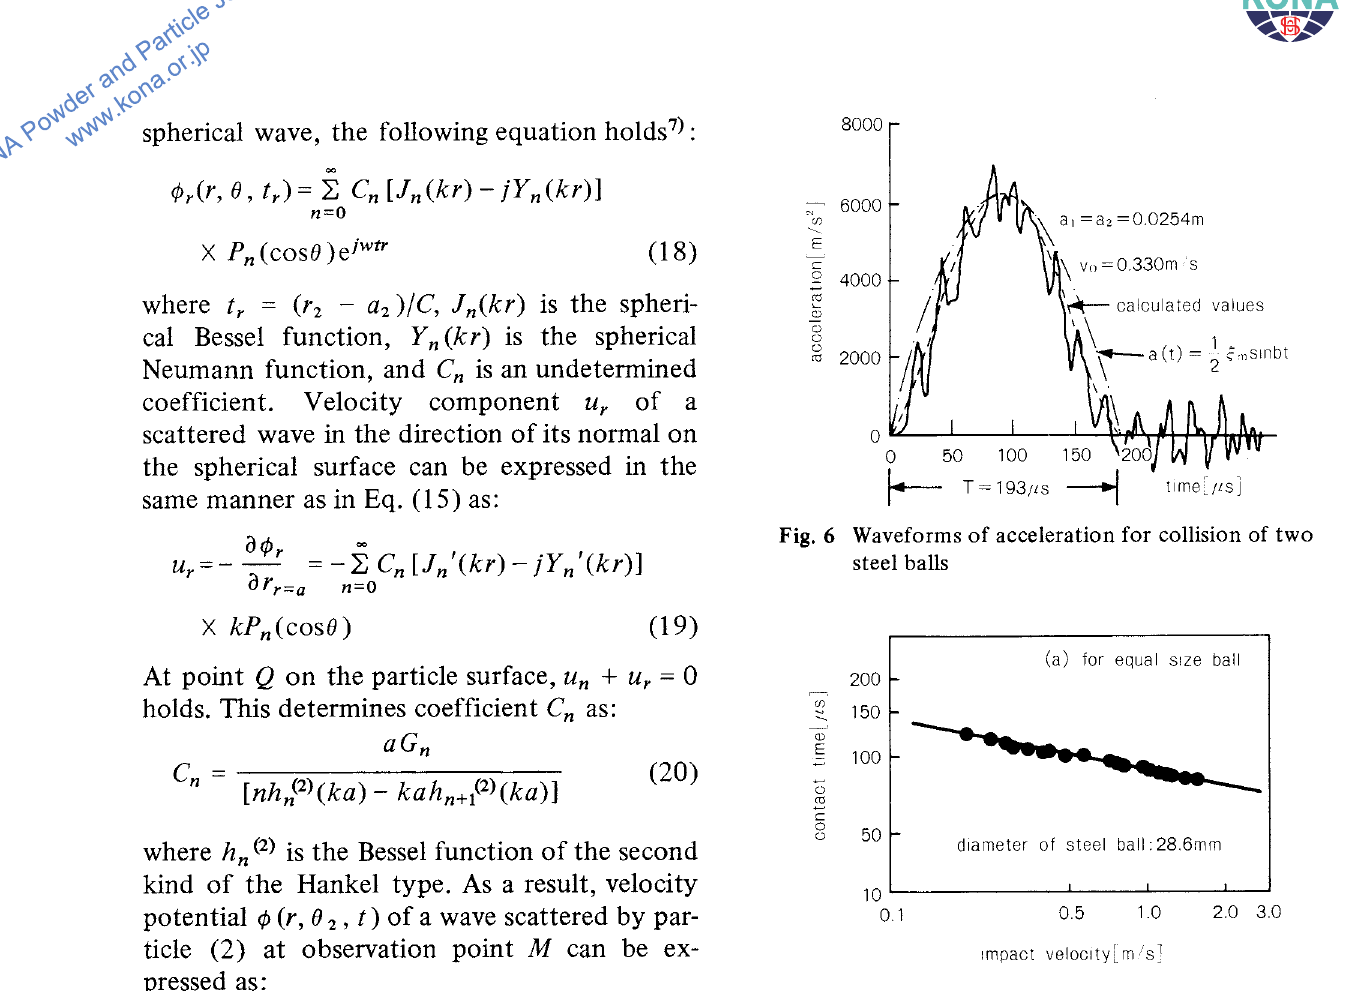
Fig. 7 Effects of impact velocity and the ratio of particle diameter on the contact time between two steel